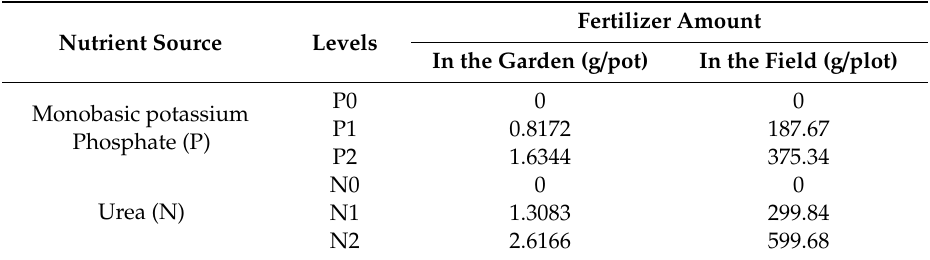
Table 1. The amounts of nitrogen (N) and phosphorus (P) fertilization based on the active ingredient of chemical fertilizers (P = monobasic potassium phosphate, N =